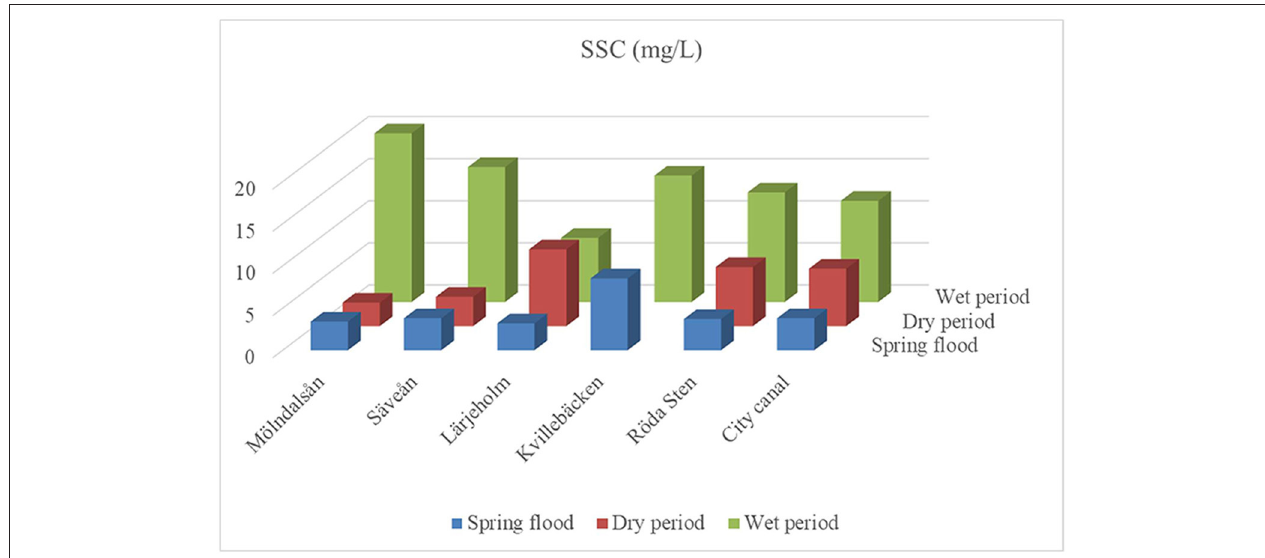
FIGURE 3 | Suspended sediment concentration (SSC) at each sampling sites and the three sampling campaigns.